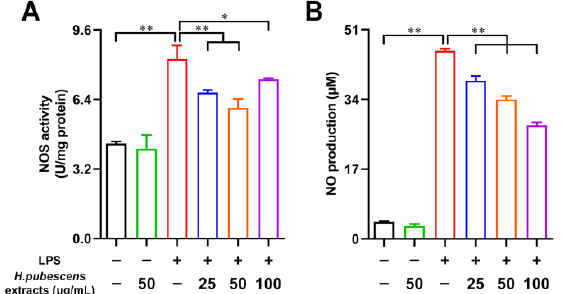
Figure 2. H. pubescens extracts reduced the NOS activity and NO level in LPS-irritated DCs. ( A , B ) DCs were cultured with the designed concentrations of H. pubescens extracts or plus LPS (100 ng/mL) for 24 h. ( A ) DCs were lysed, and the intracellular NOS activity was measured using a commercial kit. ( B ) NO content in the DC supernatant was tested using Griess reagent I and II. All of the data are shown as means ± SD from three experiments. Analysis of variance (ANOVA) was employed. ** p < 0.01, * p < 0.05.